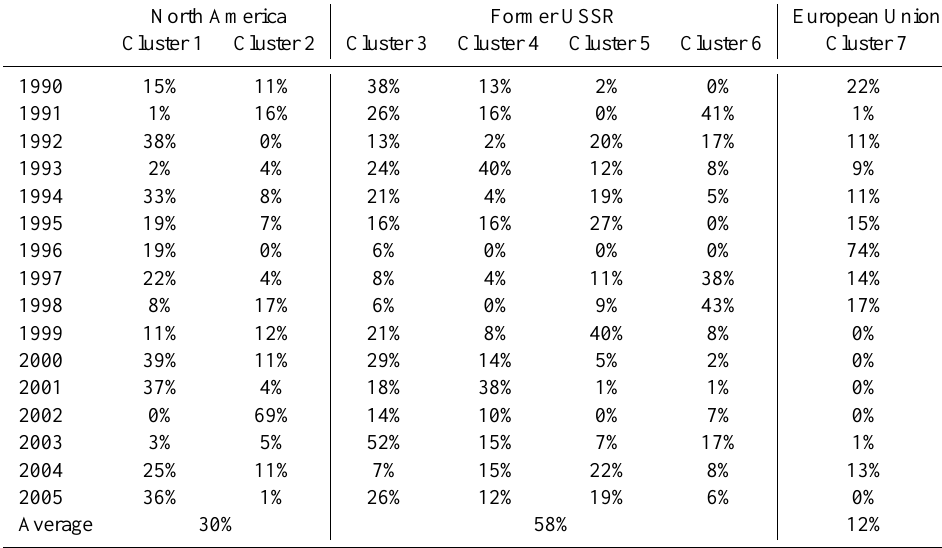
Table 2. Same as Table 1, but for April, 1990–2005.